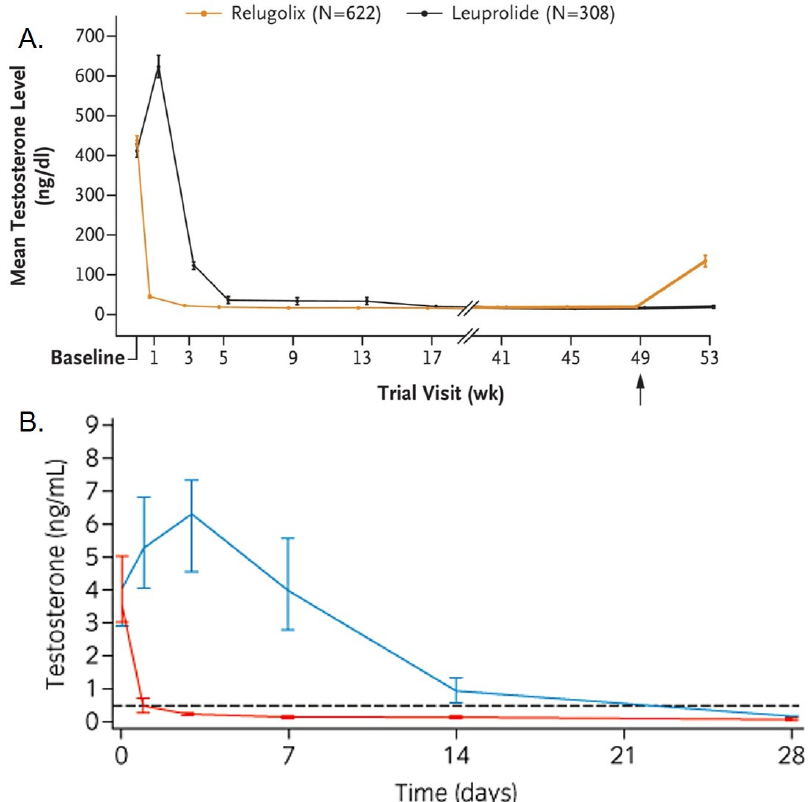
Figure 1. ( A ) Testosterone levels over time after initiation of relugolix (orange) or leuprolide (black) from the HERO trial. Reproduced with permission from the New England Journal of Medicine, Shore, N.D.; Saad, F.; Cookson, M.S.; George, D.J.; Saltzstein, D.R.; Tutrone, R.; Akaza, H.; Bossi, A.;